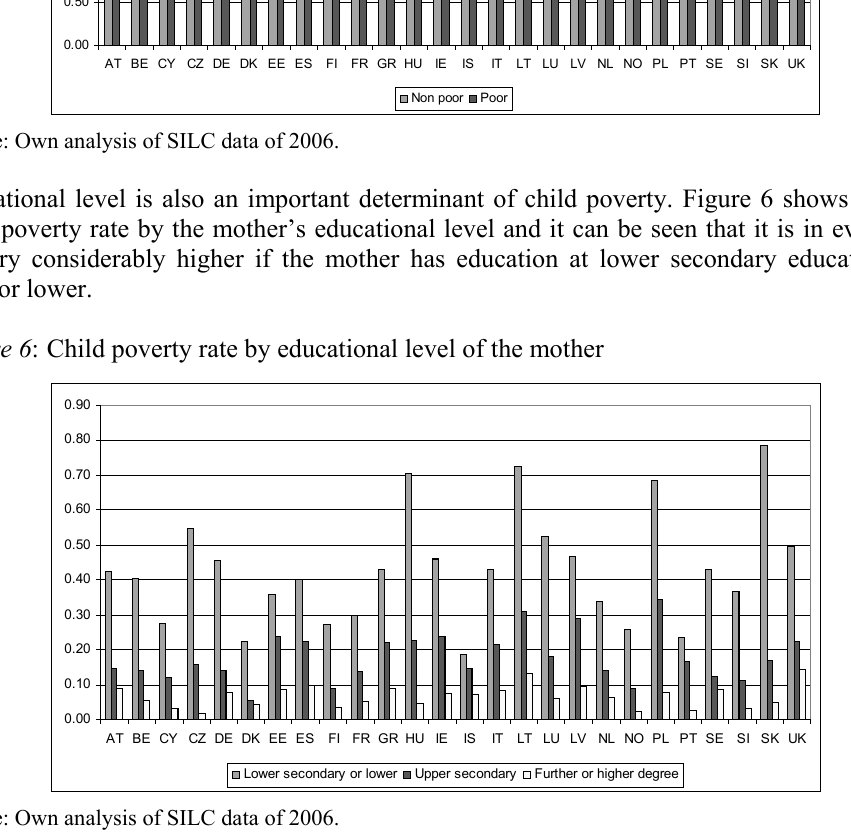
Figure 5 : Average number of children by poverty 0.000.501.001.502.002.503.003.50